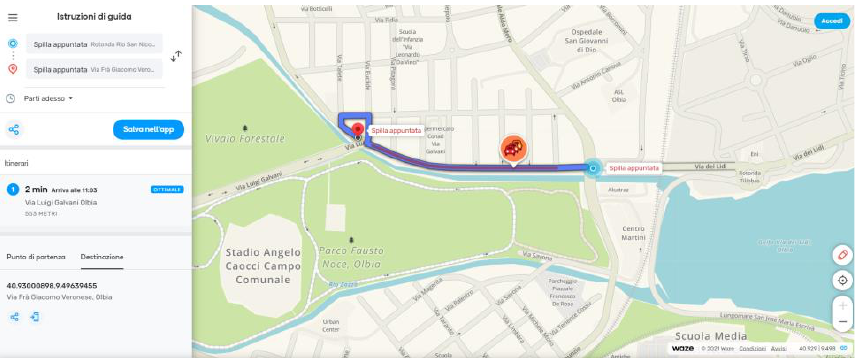
Figure 4. An example of data collection.